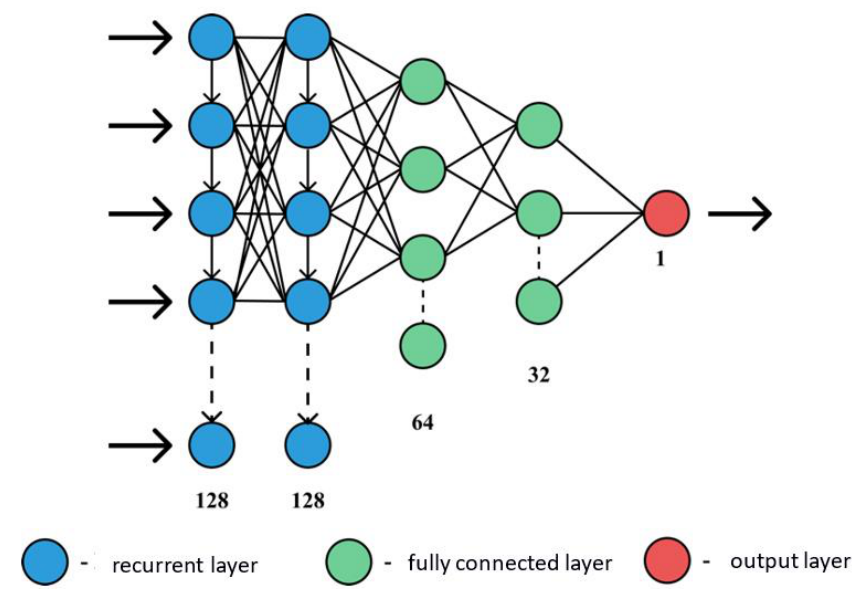
Figure 2. Neural network architecture for assessing changes in the values of the angles of rotation, tilt of a mobile phone, and voice parameters.